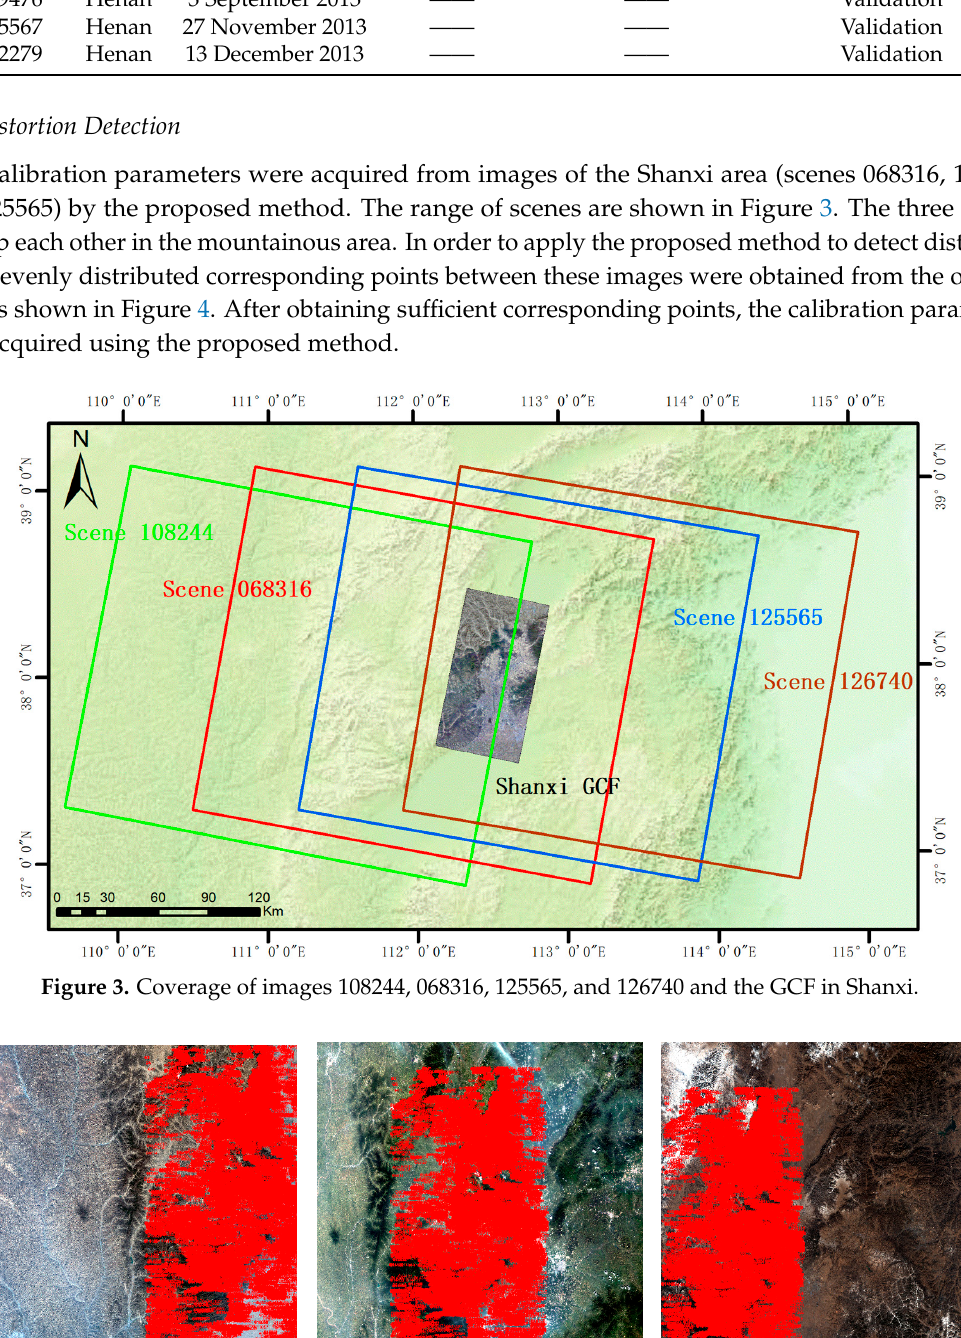
Table 3. GF-1 WFV-1 images used in method validation.